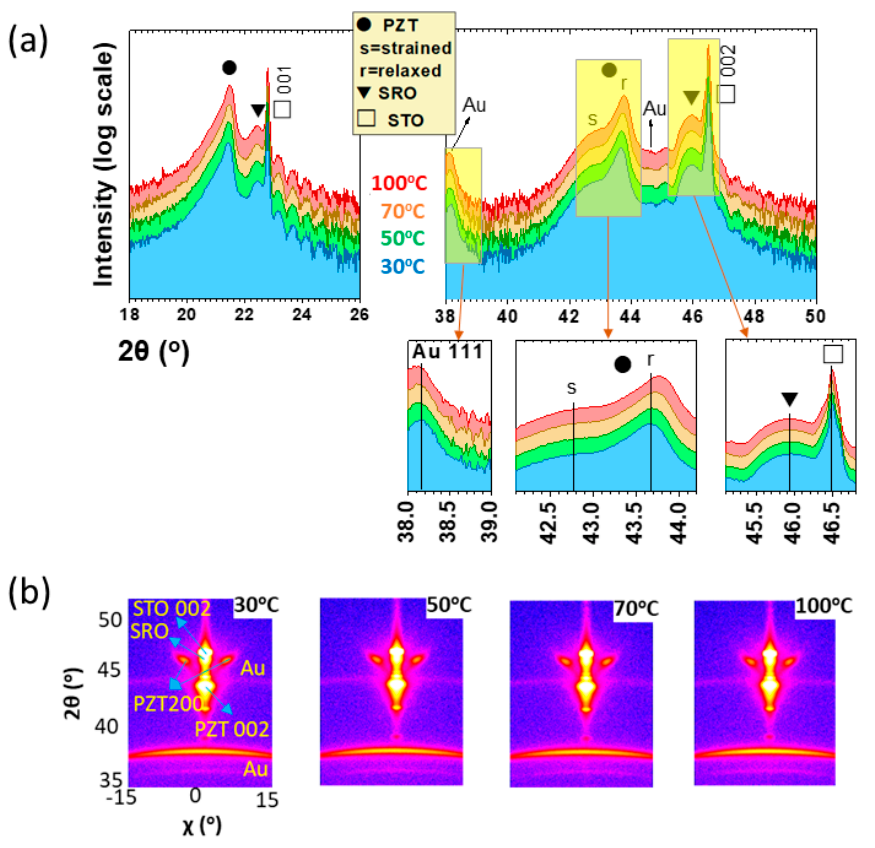
Figure 3. XRD measurements at different temperatures: ( a ) 2 θ ω scan; ( b ) reciprocal space mapping around 002 STO.; the spots indicated as PZT 200 originate from tilted PZT-a domains [37].